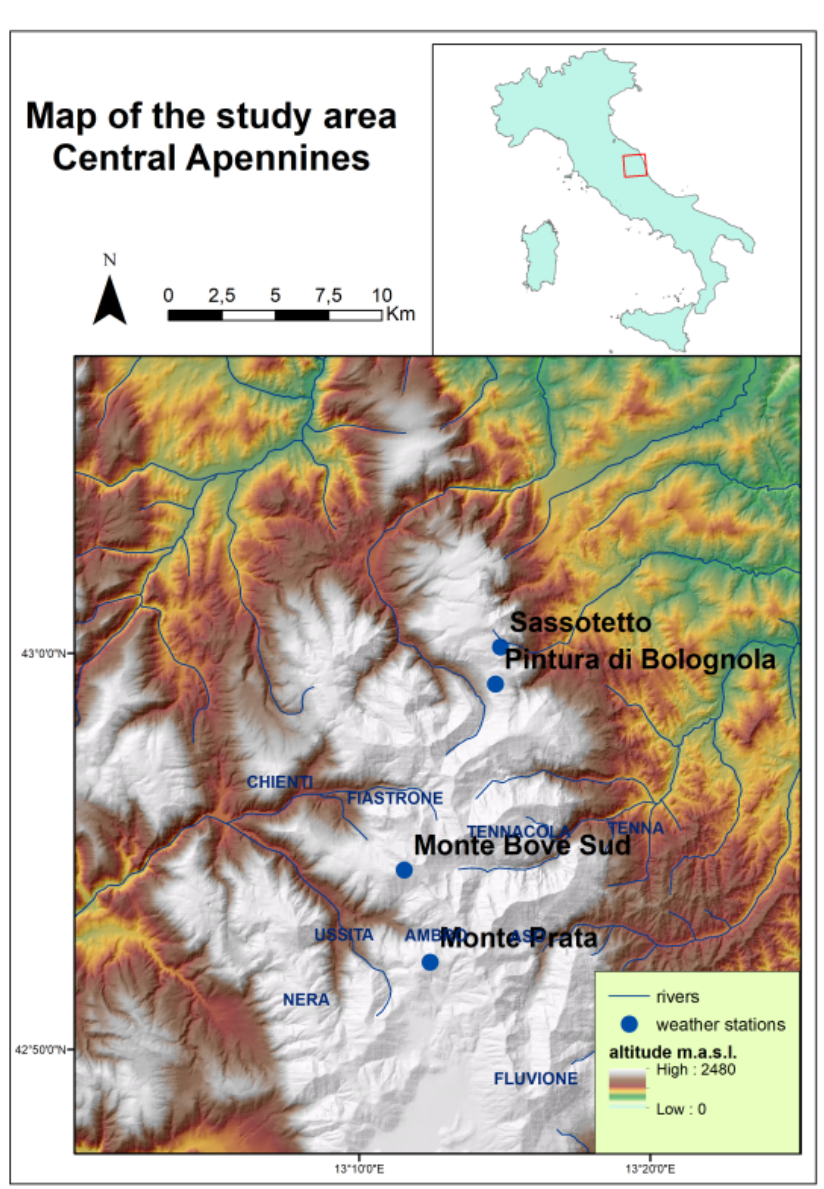
Figure 1. Geographical map of the study area with the hydrography of the area and names of the major rivers originating in the Sibillini Massif. Topographic database (DEM) Tinitaly [56].